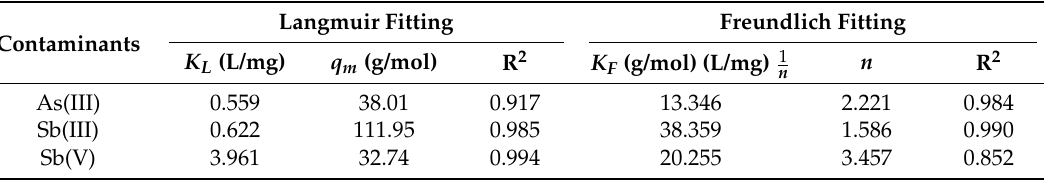
Table 1. Adsorption isotherm parameters of As(III) and Sb(III, V) on FC precipitates in the single solute